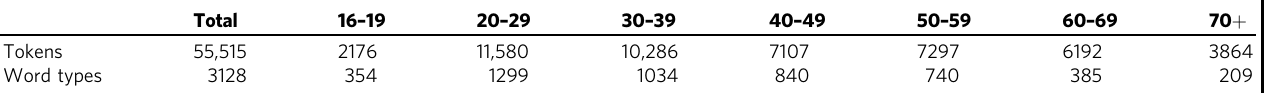
Table 2 Number of tokens and word types in the subsamples of respondents in different age